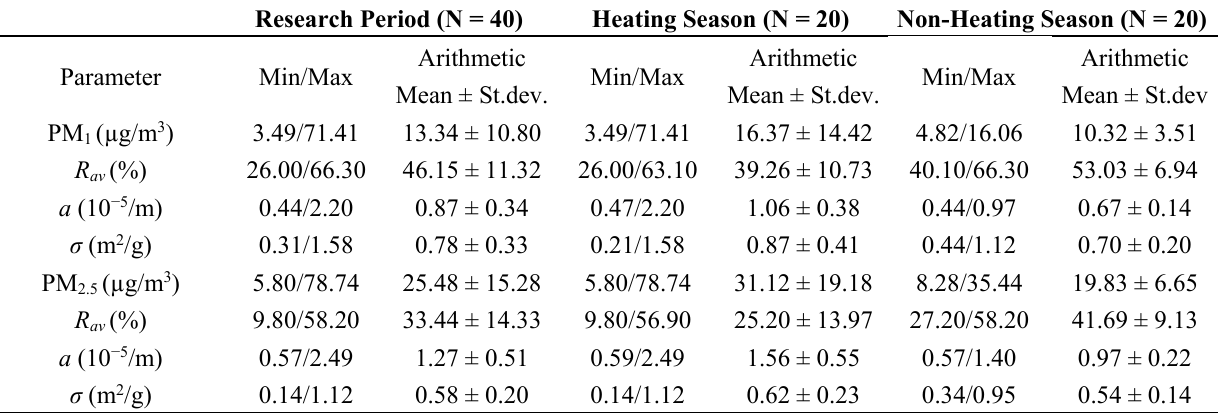
Table 1. Descriptive statistics for the optical parameters of particulate matter (PM 1 ) and PM 2.5 at RB (regional background site).